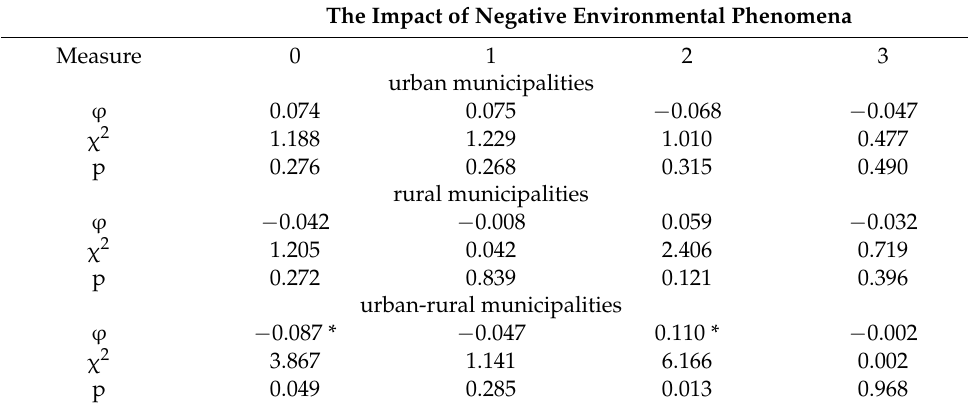
Table 5. Values of ϕ -Yule correlation coefficients between the impact of negative environmental phenomena and the surface area of green spaces in urban, rural and urban–rural municipalities. The Impact of Negative Environmental Phenomena Measure 0